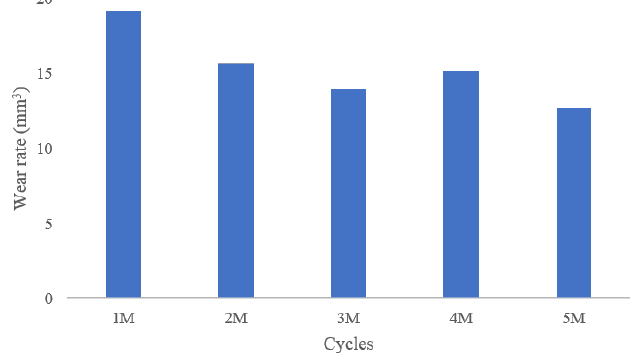
Figure 8. The experimental wear rate in the optimal model per every 1M cycles.